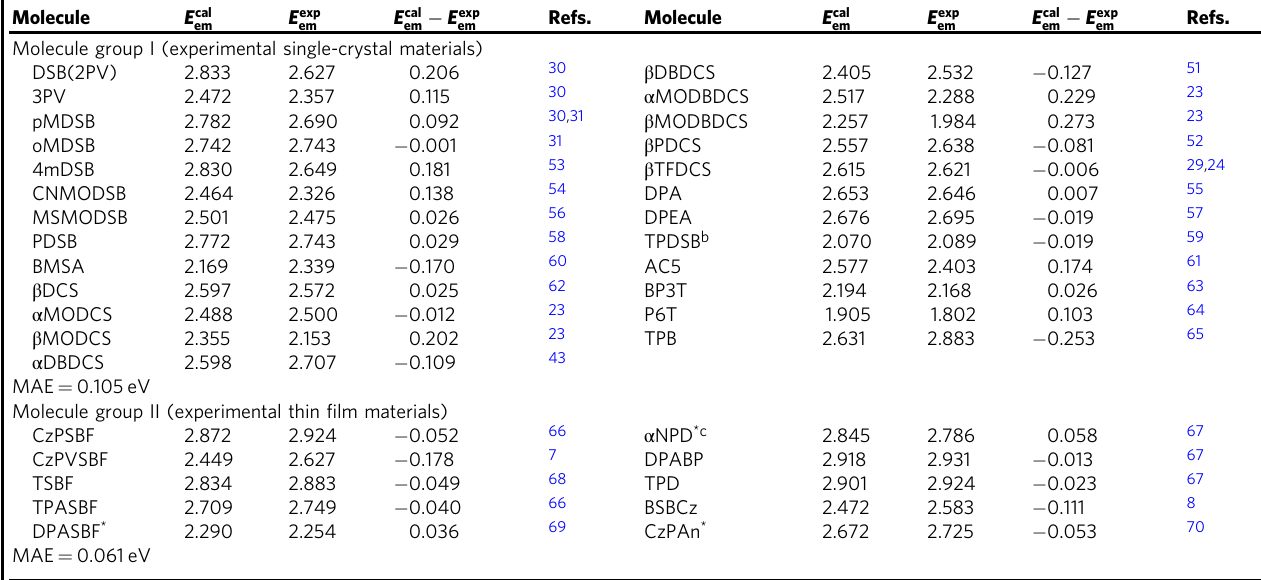
Table 1 Comparison between the computational and experimental emission energies of investigated materials a . E exp E cal (cid:1) E exp Molecule E cal Refs. Molecule Refs. em em em em